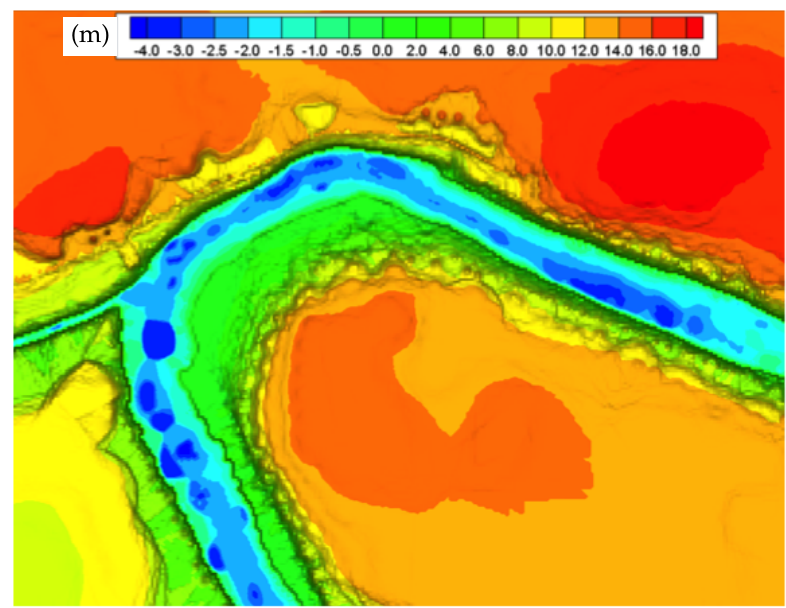
Figure 5. Topography and bathymetry of the region under study of Tampaón River.